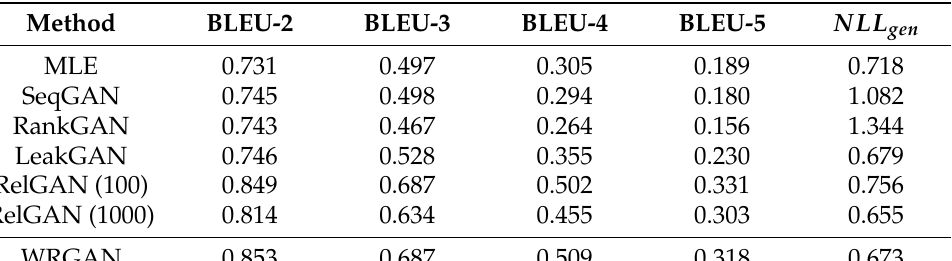
Table 2. The bilingual evaluation understudy (BLEU) and NLL gen scores on COCO Image Captions where Dimension = 128. For BLEU scores, the higher the better. For NLL gen , the lower the better.